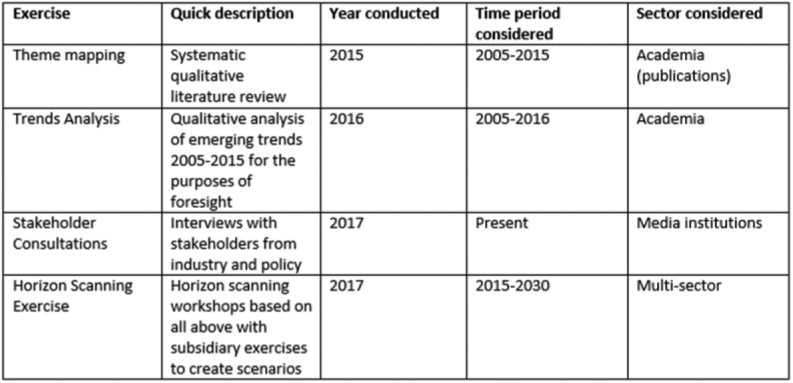
CEDAR’s methodology.